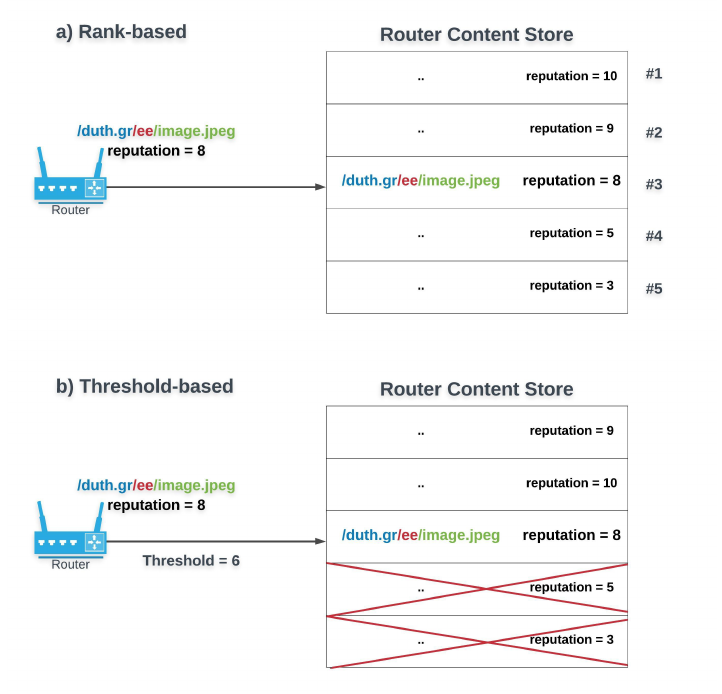
Figure 5. ( a ) Rank-based vs ( b )